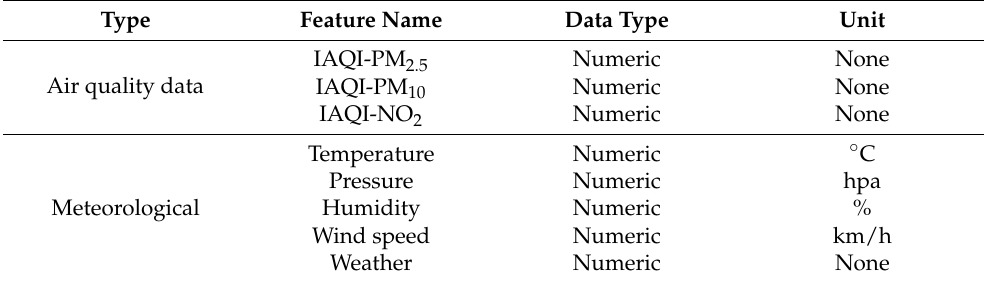
Table 1. Data set description.